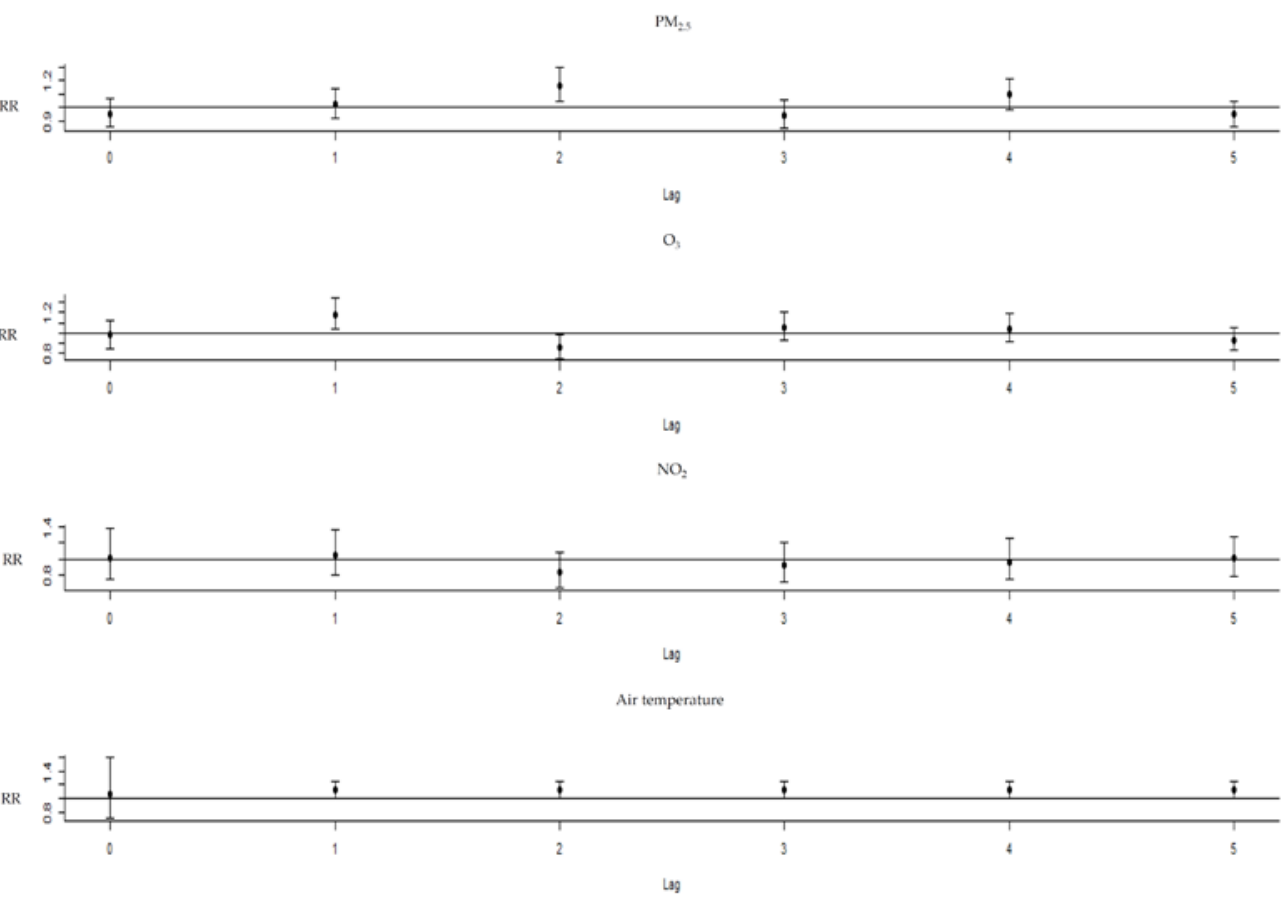
Figure 4. Lag−response curve of the cumulative effects of PM 2.5 , O 3 , NO 2 and air temperature. Table 1. The asthma emergency room visits, air pollutants and meteorological factors in Longtan district over 4 years (2016–2019).